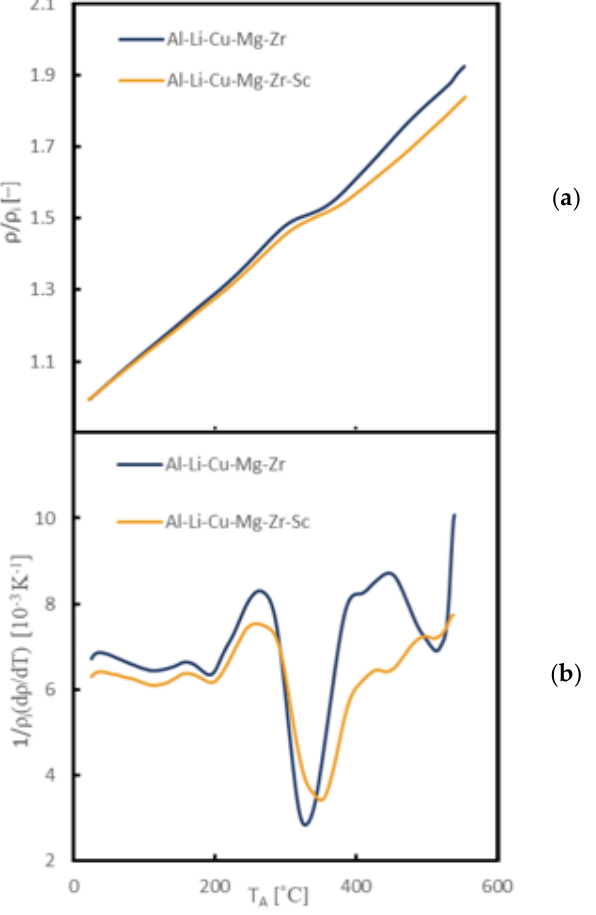
Figure 5. Evolution of resistivity in two Al-Li based alloys during linear heating ( a ). Temperature derivative of resistivity curves ( b ).